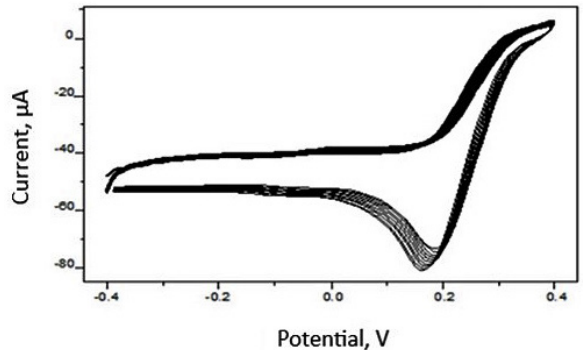
Figure 4. Repetitive cyclic voltammogram of RGO/GCE in 0.01 mol L –1 H 2 SO 4 solution containing 3 mmol L –1 HAuClO 4 and 0.01 mol L –1 Na 2 SO 4 at a scan rate of 0.050 V s –1 in the potential range of (−0.4) – (0.4) V.